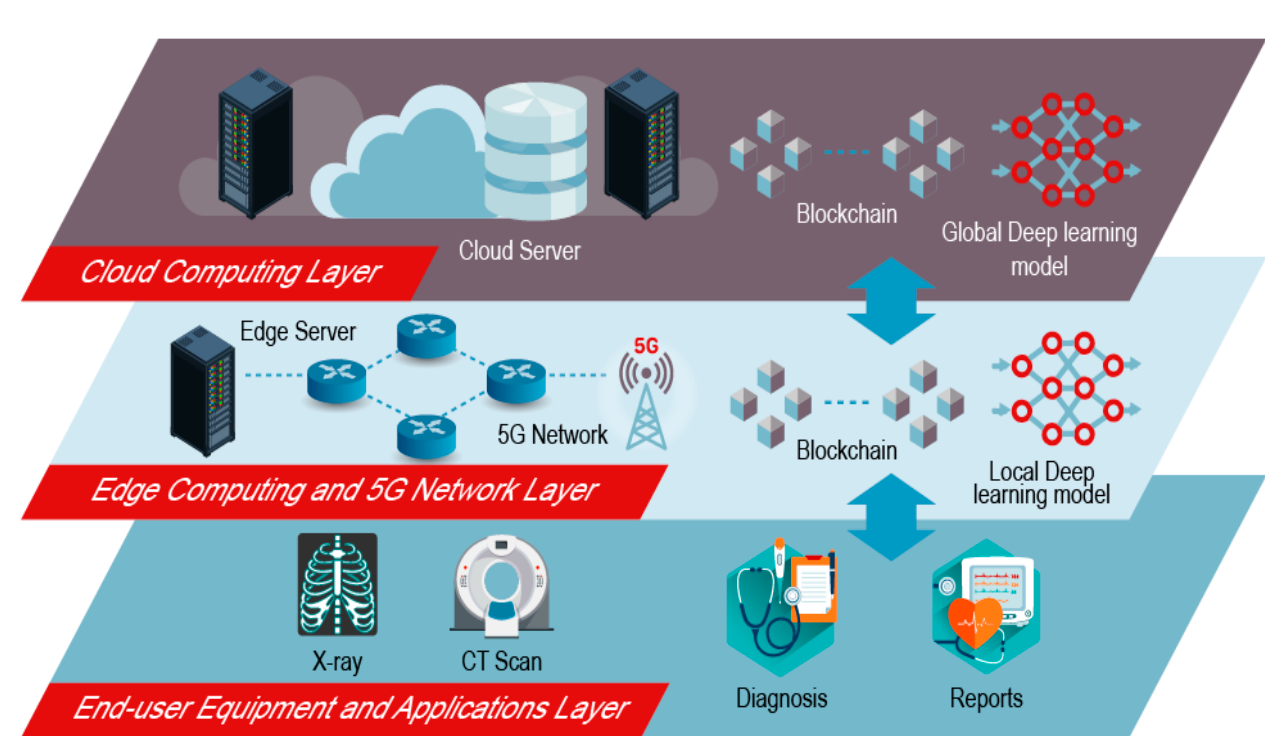
Figure 2. The three-layer architecture of the proposed framework.